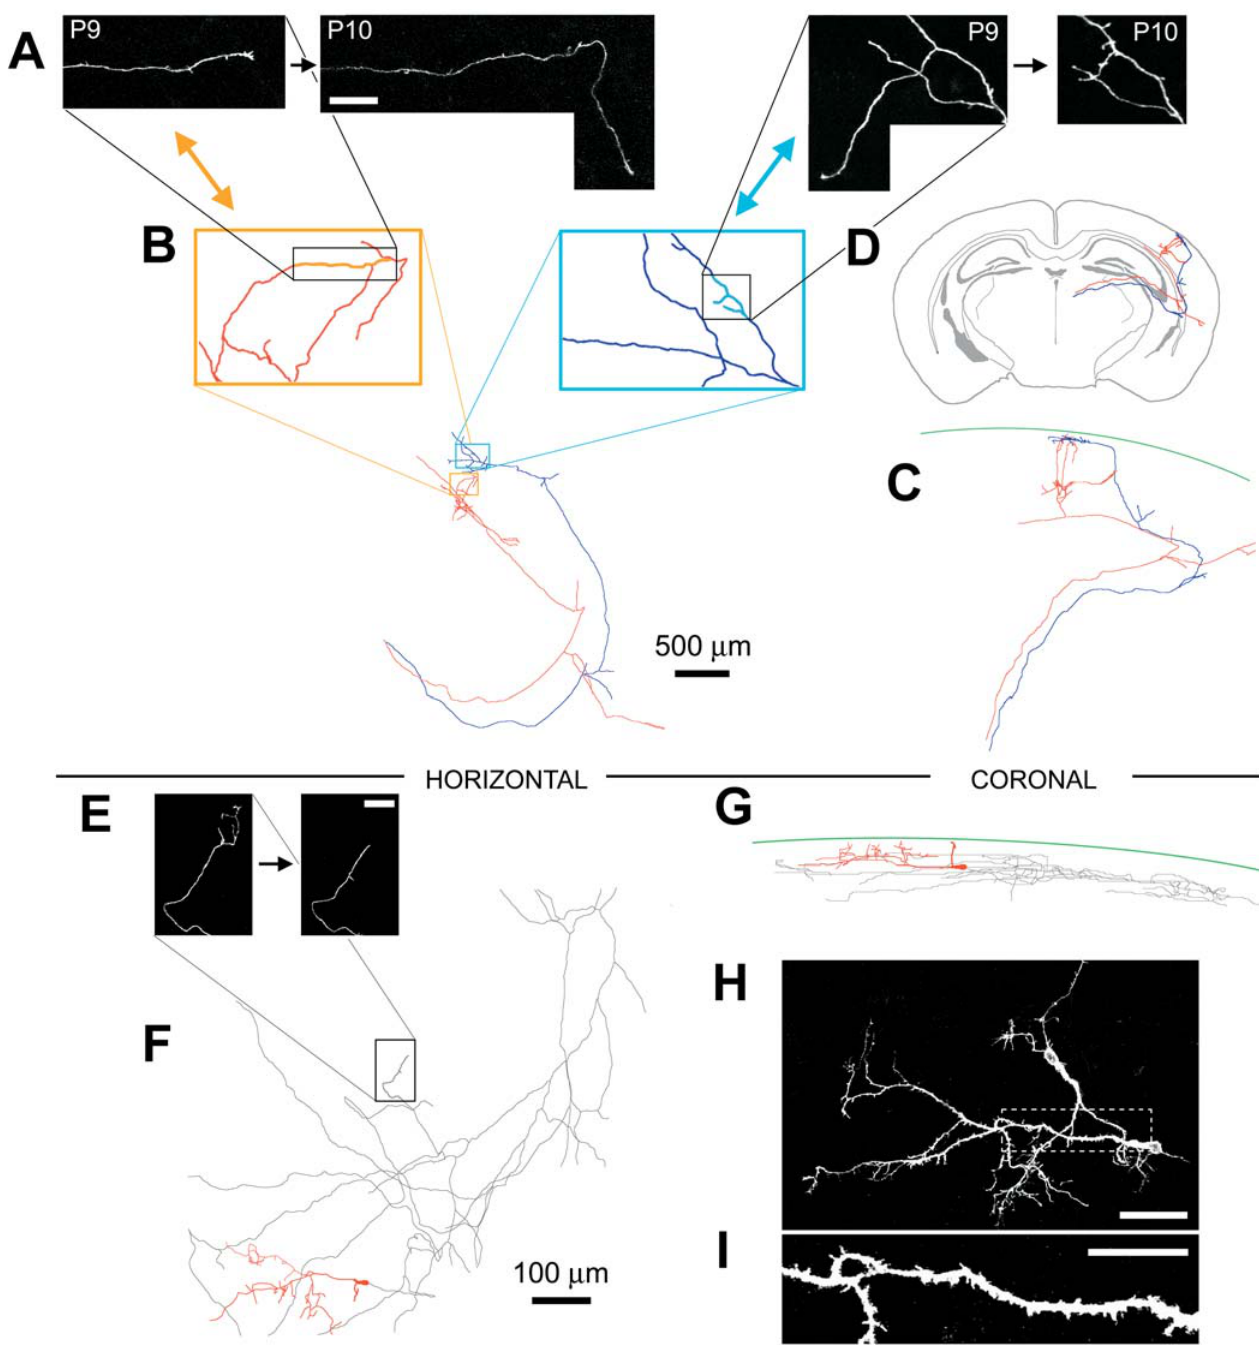
Figure 1. Long-Term In Vivo Two-Photon Imaging of TC and CR Axons in Layer 1 (A and B) Time-lapse images of two different TC axons. (A) The left photomicrographs (corresponding to the orange box in B) are projections of 19 sections; the right (corresponding to the blue box in B) are projections of of 11 sections. Scale bar ¼ 50 l m. (B) Orange and blue boxes contain axons, in horizontal view, reconstructed with BREBIS (see Figure S2E; Materials and Methods) after the last imaging session (P14). The black boxes in (B) correspond to the fields of view of the in vivo images in (A). (C) Axons reconstructed with BREBIS (see Figure S2E; Materials and Methods) in coronal view. The position of the pia is indicated in green. (D) Overlay of the coronal view in (C) on a cartoon of a generic adult mouse brain. (E) Time lapse images of a CR axon (left, 12 sections; right, eight sections). Scale bar ¼ 100 l m. (F and G) Axonal arbor of a CR neuron (gray) imaged in vivo in (E). Views are horizontal (F) and coronal (G). The CR soma and dendrites are drawn in red. (H) Image of the CR dendritic arbor shown in a projection of 14 sections. Note that there are two CR neurons in this image, including the horizontally oriented neuron we traced in red in (F) and (G). Scale bar ¼ 50 l m. (I) High-magnification view of CR dendritic spines (projection of five sections). Scale bar ¼ 25 l m. DOI: 10.1371/journal.pbio.0030272.g001